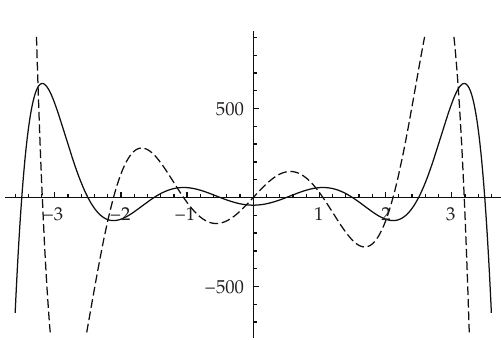
Figure 3: G (cid:3) x (cid:4) (cid:3) solid (cid:4) and G (cid:2) (cid:3) x (cid:4) (cid:5) g (cid:3) x (cid:4) (cid:3) dashed (cid:4) .